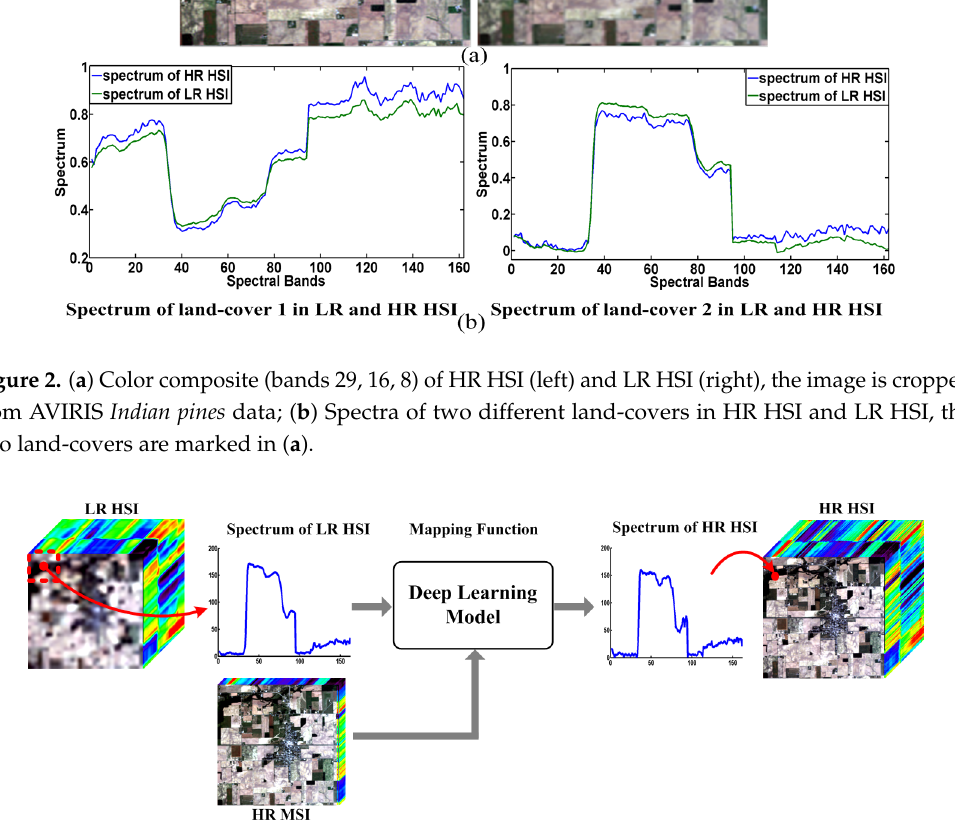
Figure 3. The proposed scheme of deep learning based HSI-MSI fusion.